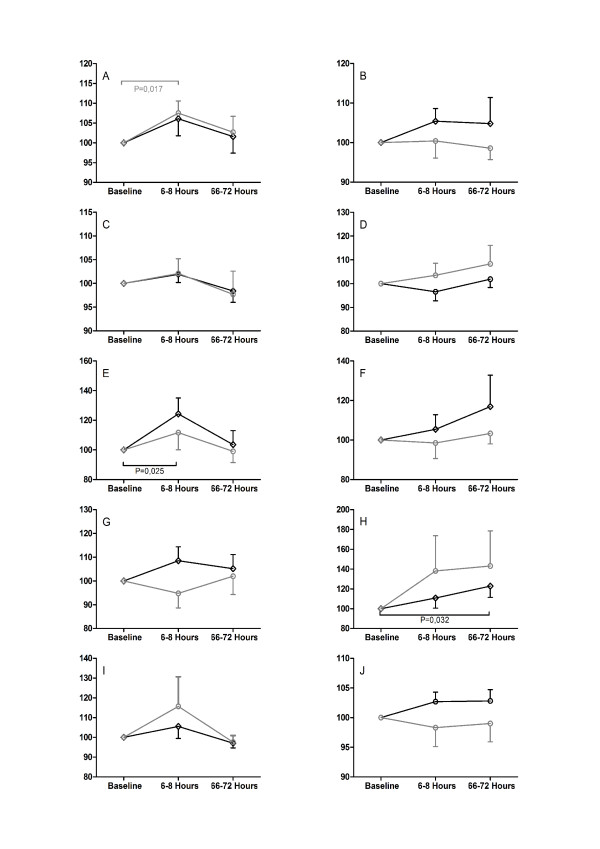
TAP. Cognitive function assessed with the TAP. Subtests Alertness (A+B), Divided Attention (C+D), Visual Scanning (E+F), Working Memory (G+H) and Reaction Change (I+J). Figure pairs show reaction time on the left and valid reactions on the right. All values are Mean (SEM) and display the change at 6-8 and 66-72 hours normalized to the preoperative baseline. All ordinates are in per cent. Grey lines and open circles display the xenon group, black lines and open squares represent the sevoflurane group.